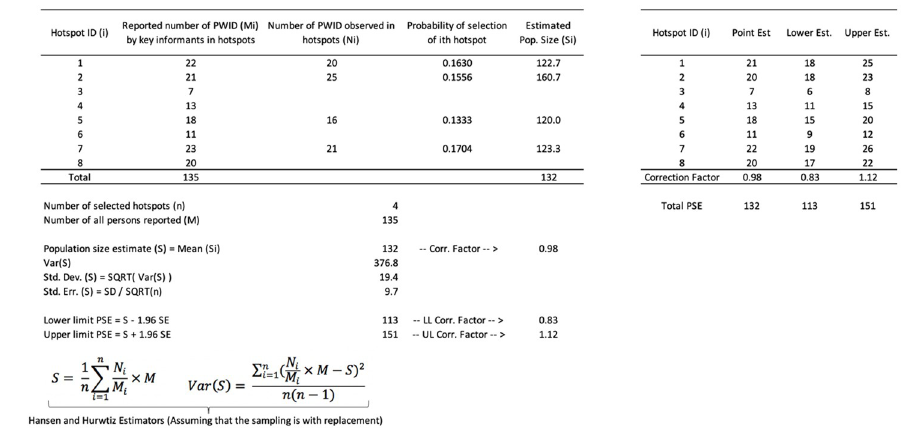
Fig 2. Steps to estimate the number of people who inject drugs in each hotspot by key informant interviews for mapping and enumeration with reverse tracking, Afghanistan, 2019.